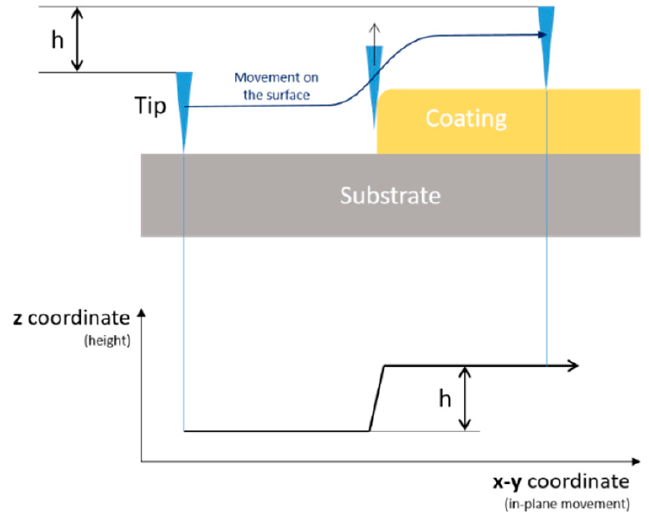
Figure 10. Line-scan performed using the “scratch method”, side-view; h represents the measured height.